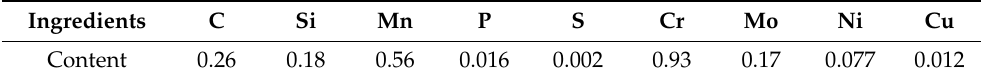
Table 1. Metal element content of 80S steel (%).